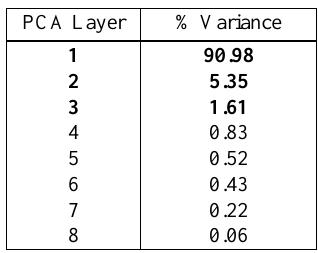
Table 1. The contribution of all principal component analysis (PCA) bands to total